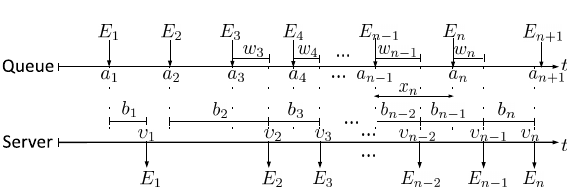
Figure 1: Model of a queueing system.